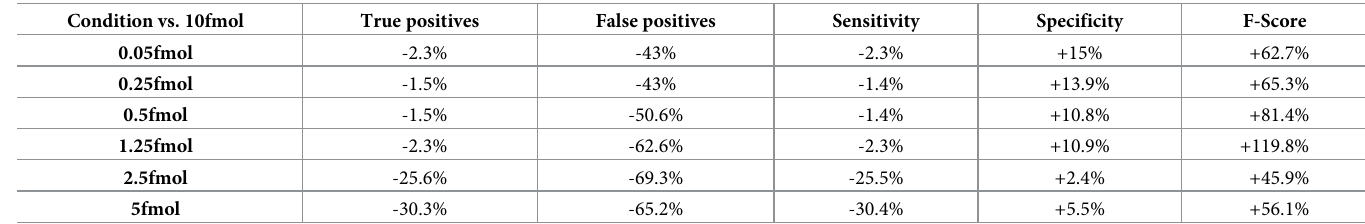
Table 4. Performance of the mi4p methodology expressed in percentage with respect to DAPAR workflow, on Arabidopsis thaliana + UPS1 experiment, with at least 1 out of 3 quantified values in each condition. Missing values (6%) were imputed using the maximum likelihood estimation method. Condition vs.